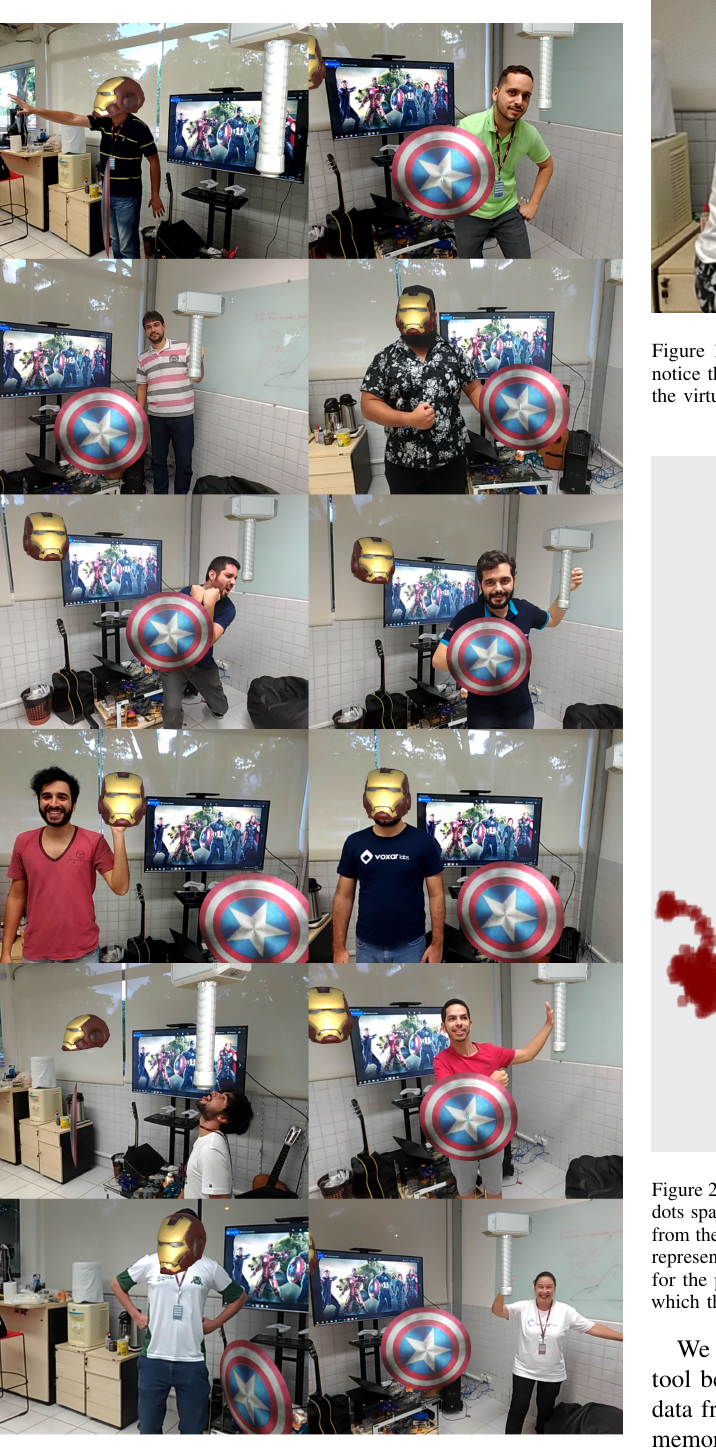
Figure 18. Pictures taken by users during tests. The 3D position from which the pictures were taken can be visualized in Figure 17